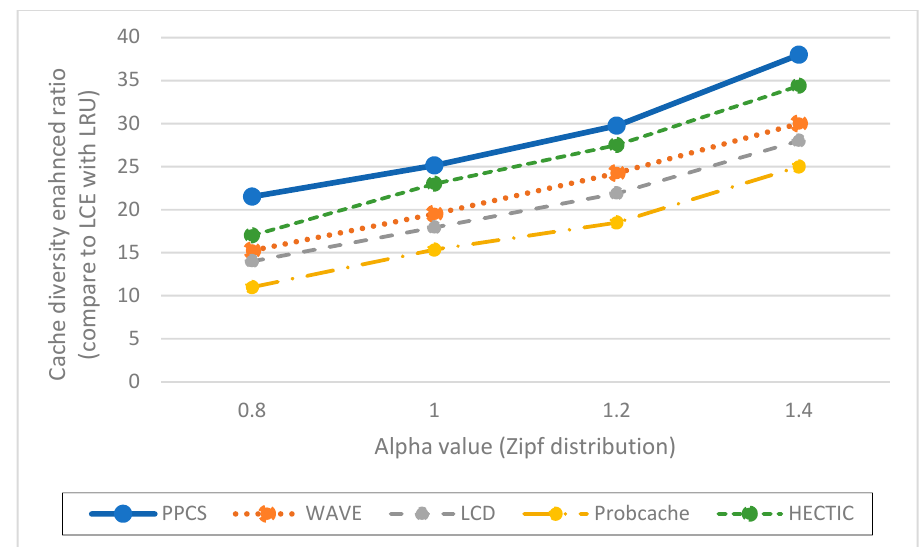
Figure 5. Hop reduction ratio versus different CS sizes.